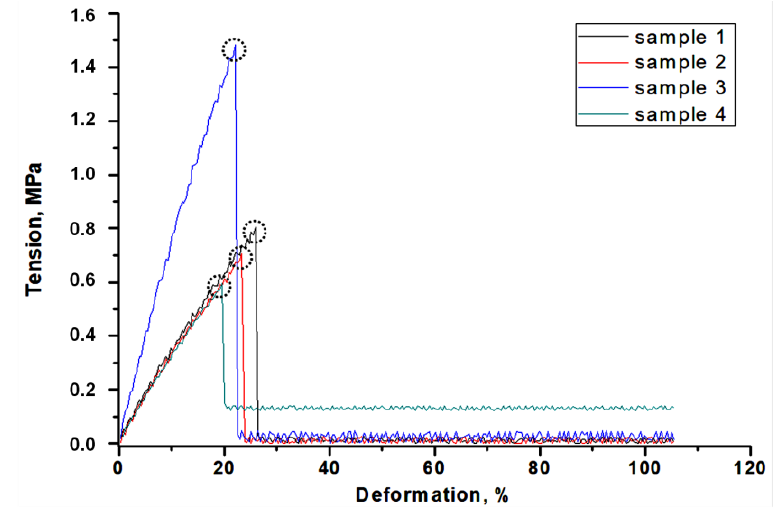
Figure 10. The scheme of the tensile strength analysis. The results of the mechanical measurements are presented in Figure 11.